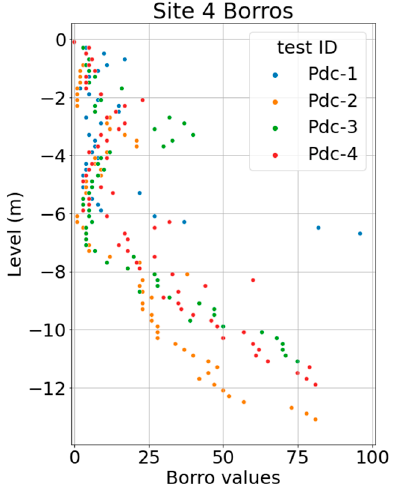
Figure 7. Borro values for site 4.